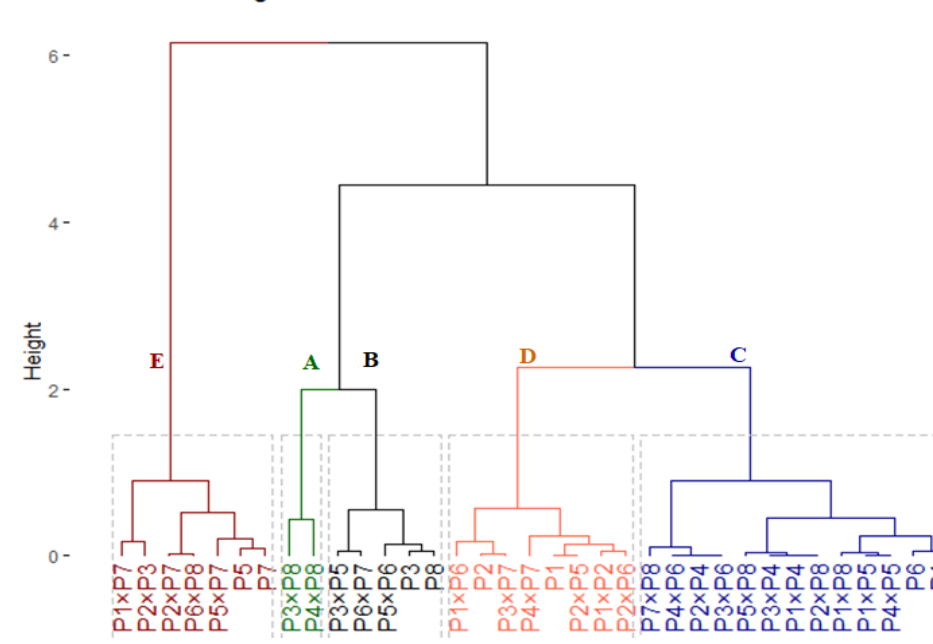
Figure 5. Dendrogram of the phenotypic distances among eight wheat genotypes and their 28 F 1 s based on 4 drought tolerance indices (GM, MP, YI, and STI).